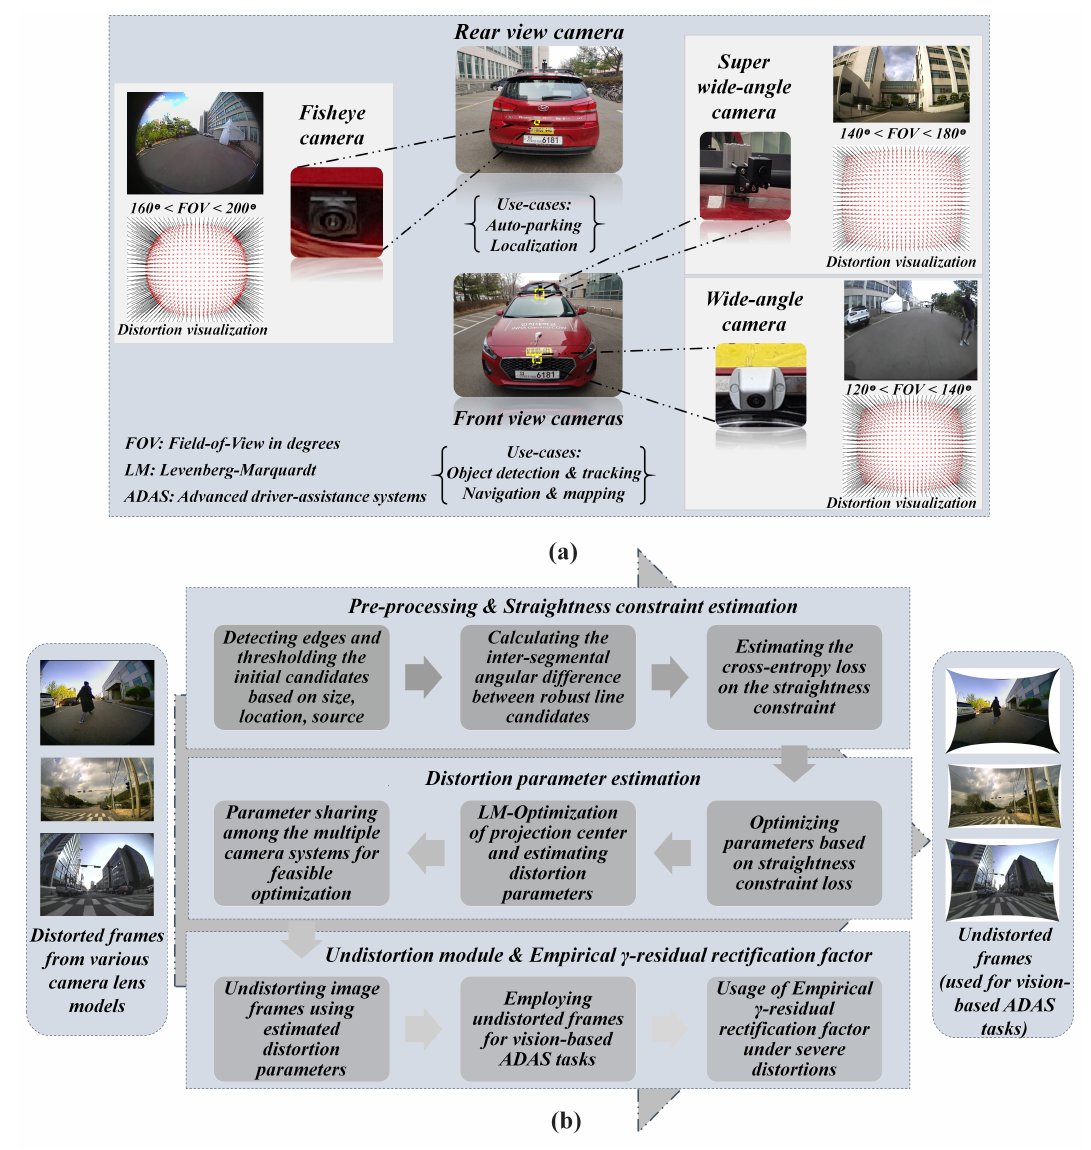
Figure 1. Proposed Pipeline on ADAS workbench ( a ) ADAS Platform: Camera sensors setup and image acquisition. ( b ) Proposed method with block